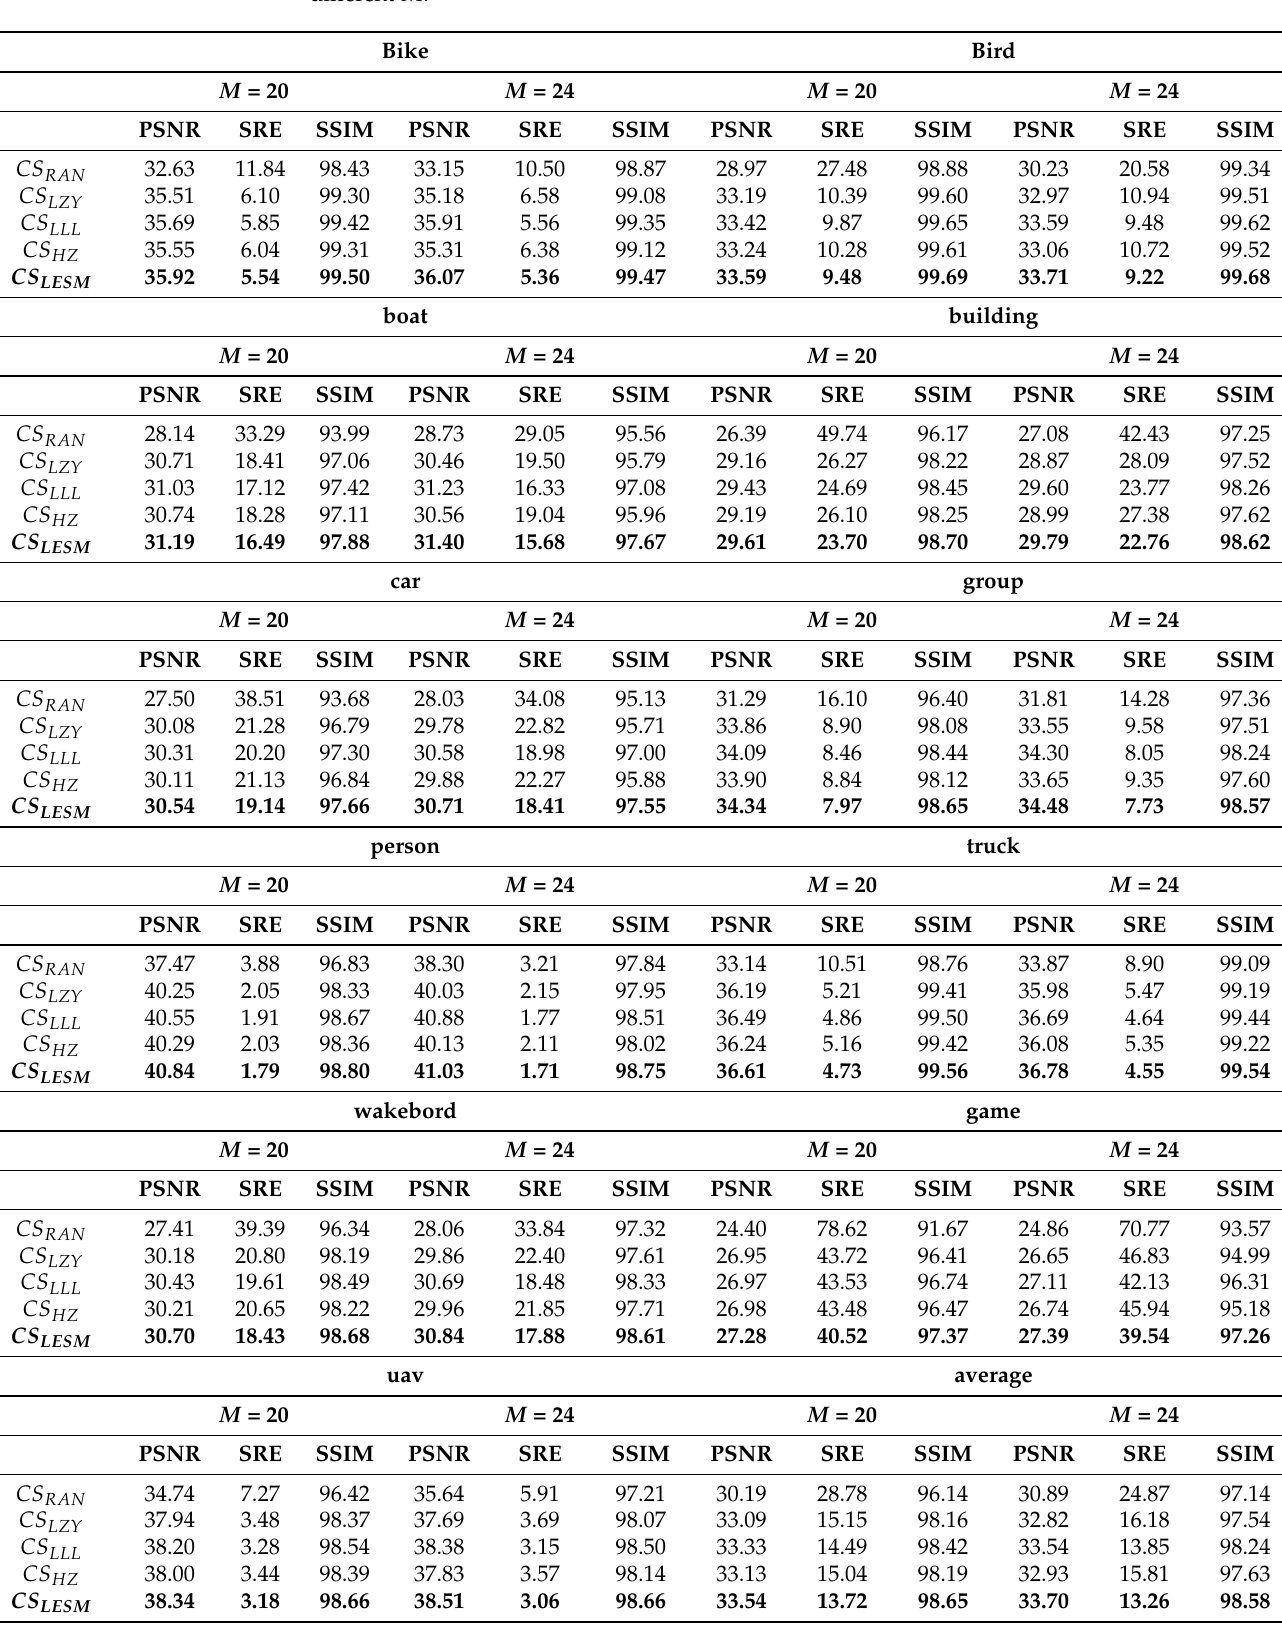
Table 2. The PSNRs (dB), SREs and SSIMs (%) of VAU images for five sensing matrices with different M